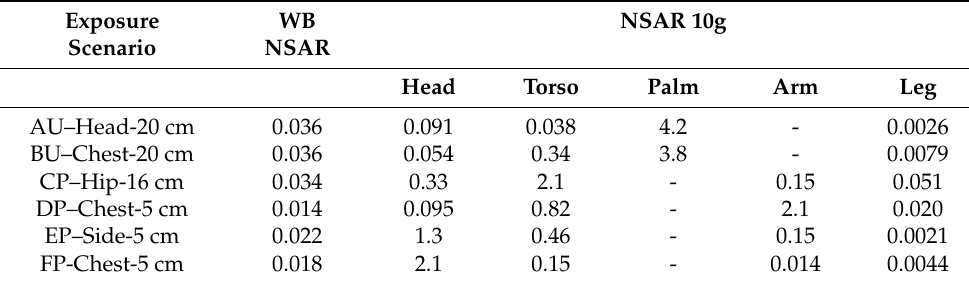
Table 8. Whole body averaged and local SAR under exposure to an EMF at a frequency of 865 MHz emitted by the UHF-RFID gun reader; values normalized at level of the EMF emission from an RFID at 1 W (ERP), (6 min continuous exposure).